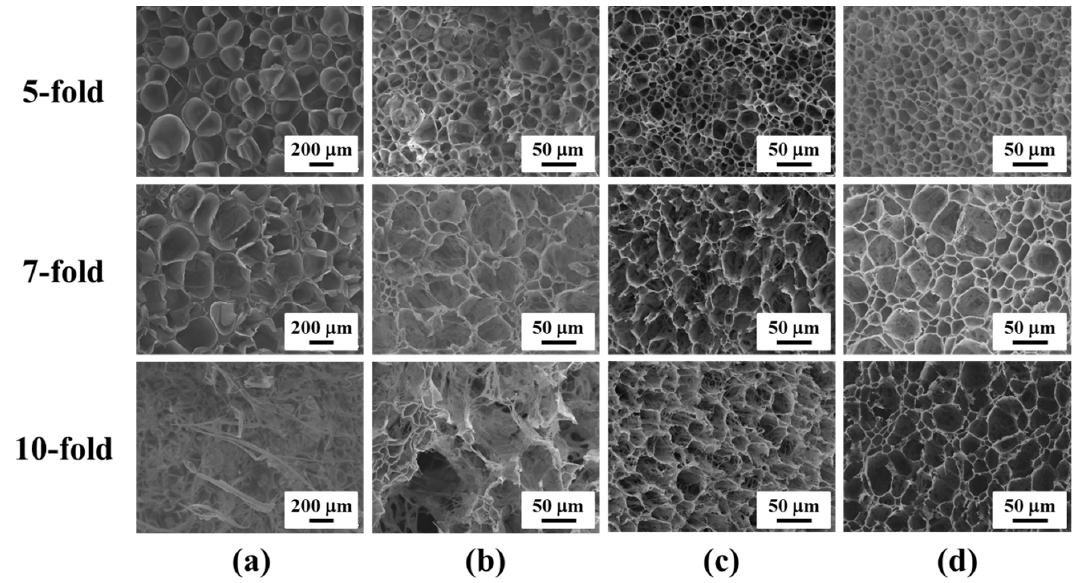
Figure 3. SEM micrographs of the cross-section of ( a ) iPP; ( b ) CNF-0; ( c ) CNF-0.2; and ( d ) CNF-0.4 foams in the core layer with different expansion